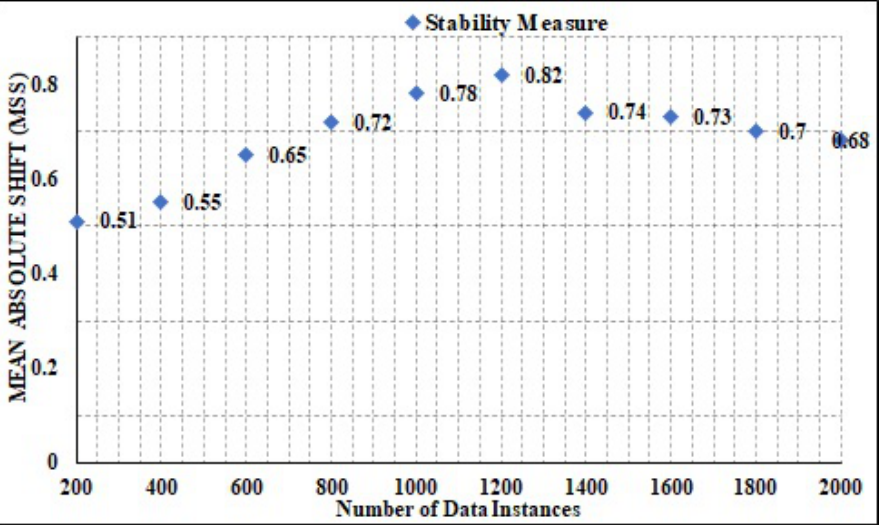
Figure 16. Stability